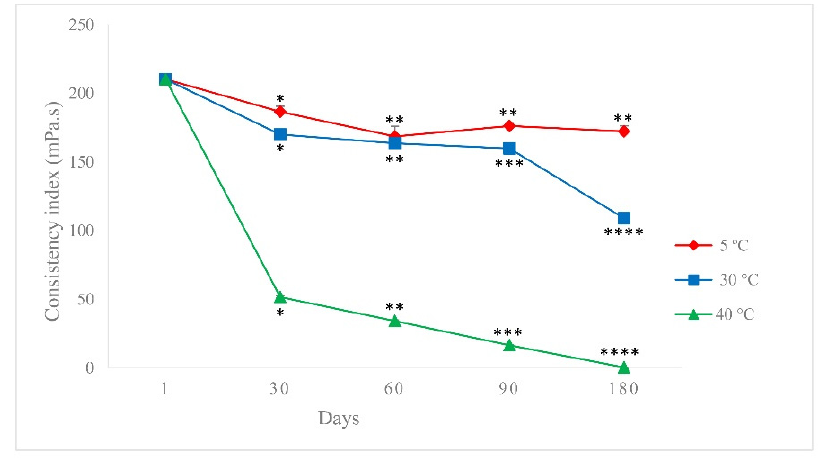
Figure 5. Consistency index of HA-based nanoemulsion containing P. pubescens oil stored at temperatures of 5, 30, and 40 °C for 180 d. Mean ± SD ( n = 3). One-way ANOVA followed by post hoc Tukey’s test; different specimens (*, **, ***, and ****) are considered statistically different at p < 0.05.